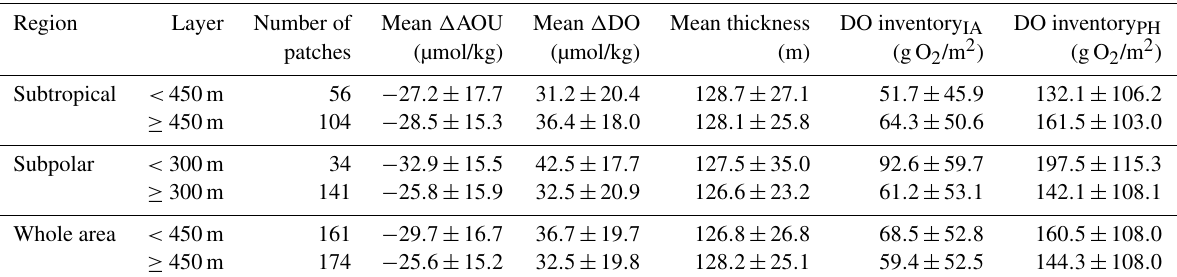
Table 1. Statistics of the subduction patches and the associated oxygen exports into the ocean’s interior. See Sect. 2.2.2 for details on the calculation of the DO inventory. Note that these statistics are based on the subduction patches identified, without considering their episodic characteristics and spatial and temporal inhomogeneity. Note that the DO inventories are the average values of the amount of oxygen injected into the ocean interior by an episodic subduction event.